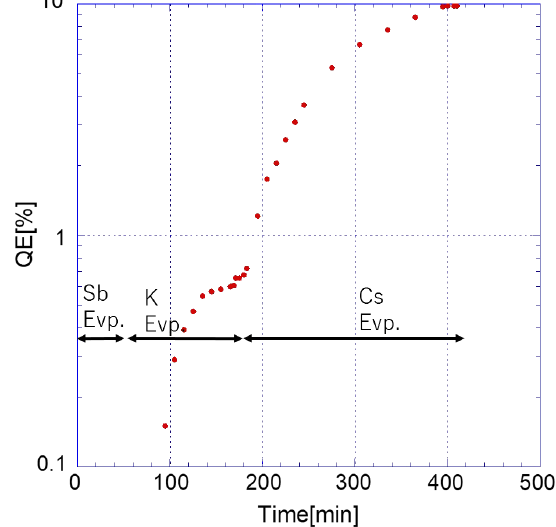
FIG. 1. QE evolution during the evaporation process. Sb, K, and Cs was evaporated on p -type Si(100) substrate in this order. QE measured by 532 nm laser was launched during K evapo- ration and much enhanced in Cs evaporation.